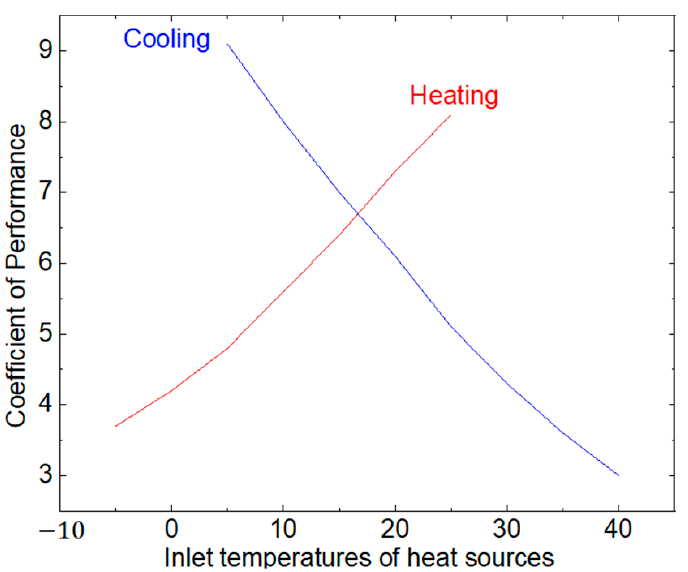
Figure 8. A schematic of a residential GSHP system for this analysis.